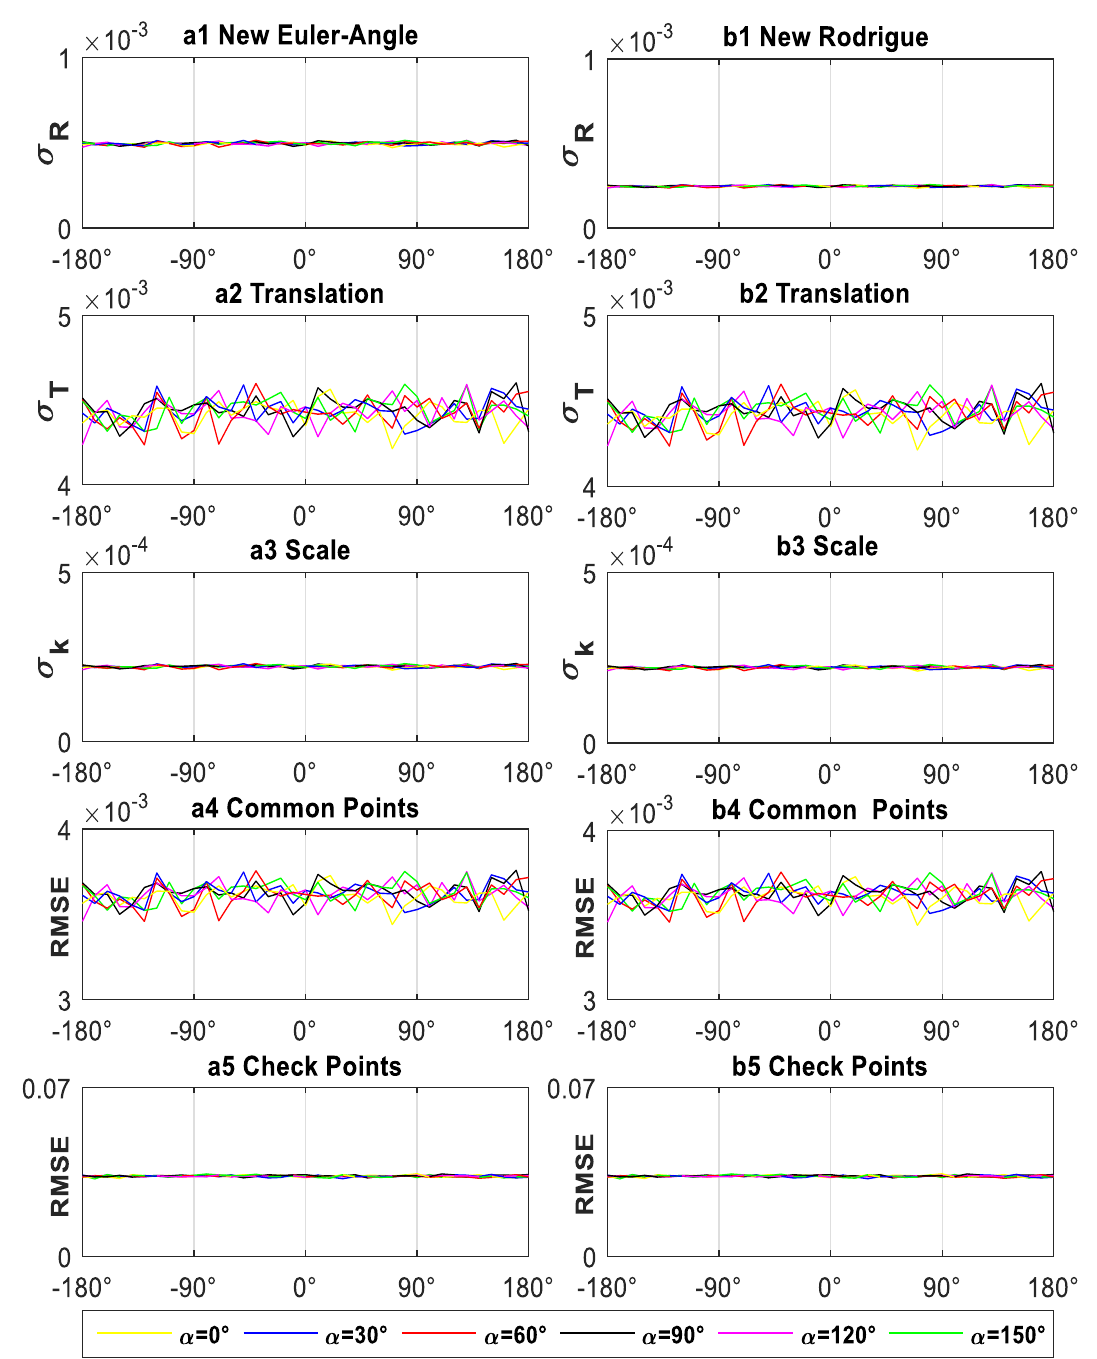
Figure 2. Transformation precision of the new transformation model for experiment I (each x axis value represents a different rotation angle, each y axis value represents a different precision for a different precision index ( a1 )-(rad), ( b1 )-(a.u.), (a.u.), (m), RMSE(m)), each color represents a different rotation axis for different, ( a1 – a5 ) shows the results of the proposed NEA-Method, ( b1 – b5 ) shows the results of the proposed NR-Method).